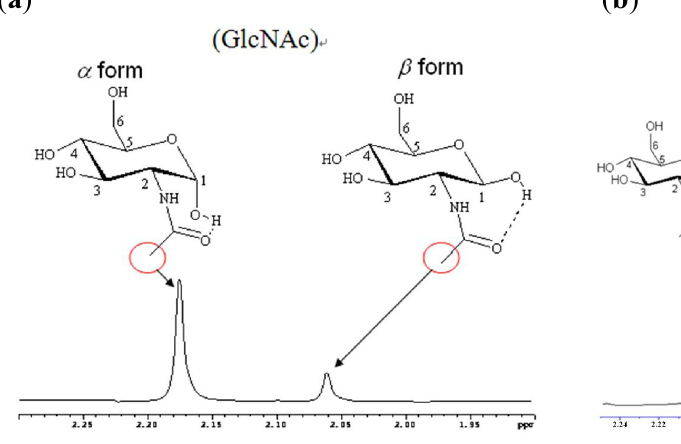
Figure 4. The chemical shift difference of ( a ) α/β form (GlcNAc) and ( b ) β-α/β-β form (GlcNAc) . 2